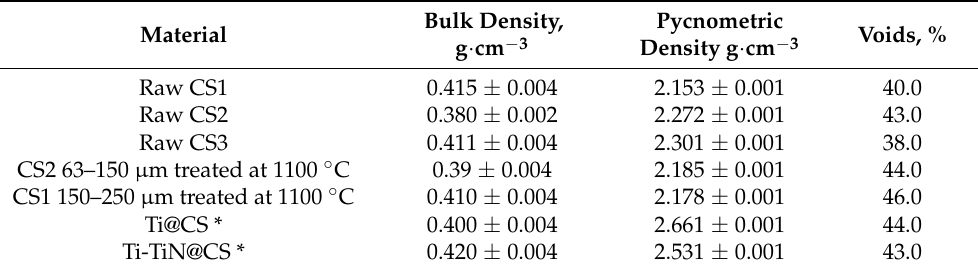
Table 2. Bulk density of CS, the density of the material, and interparticle void